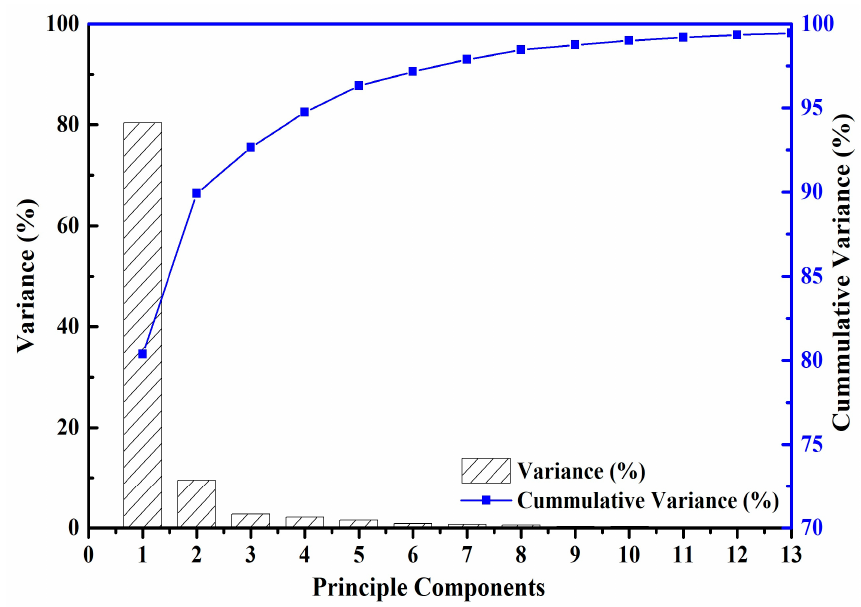
Figure 9. Scree plots displaying the explanatory capability of each principal component for the response patterns of winter wheat yield to drought by the variance percentage. The greater the variance is, the stronger the explanatory capability of the principal components owns.